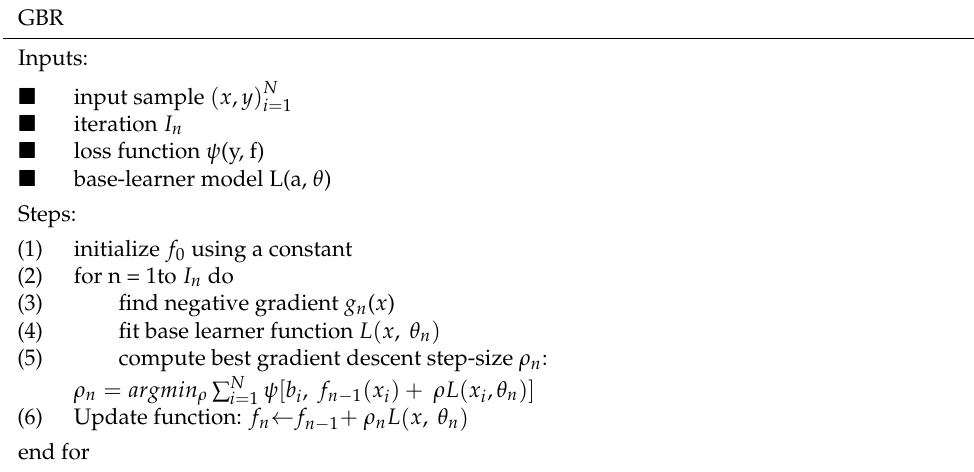
Table 3. Mathematical step-by-step explanation of the working flow of ELA representing gradient boosting regression (GBR) [35].